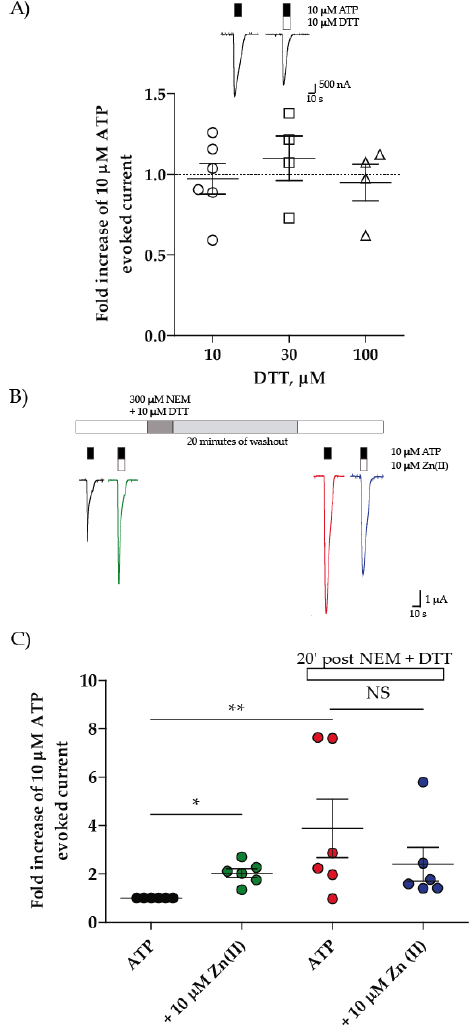
Figure 4. Dithiothreitol (DTT) plus NEM treatment annuls Zn(II) potentiation on rP2 × 4R. ( A ) quantification of the rP2 × 4R ATP evoked currents fold increase when co-applied with DTT 10–100 µM and representative traces of ATP evoked currents in absence and presence of 10 µM DTT (insert).